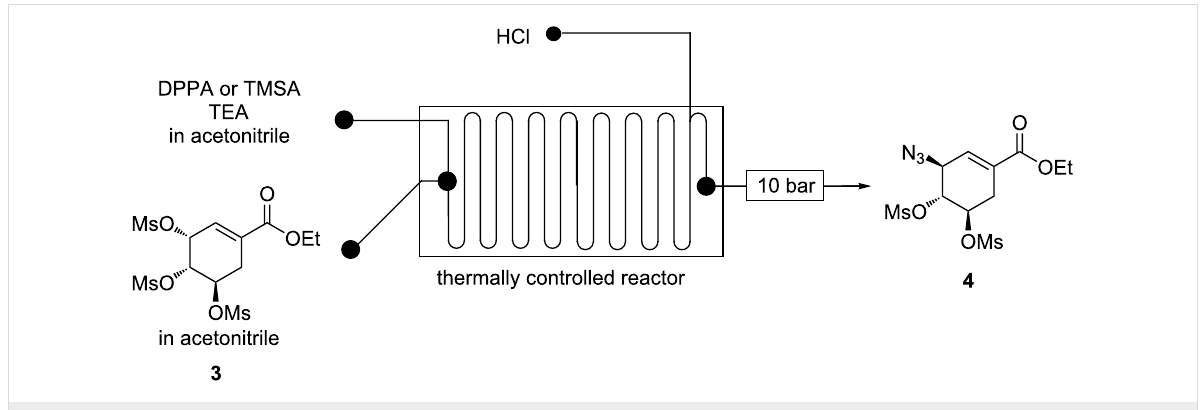
Figure 7: Continuous-flow system for C-3 azidation of mesyl shikimate using DPPA or TMSA.